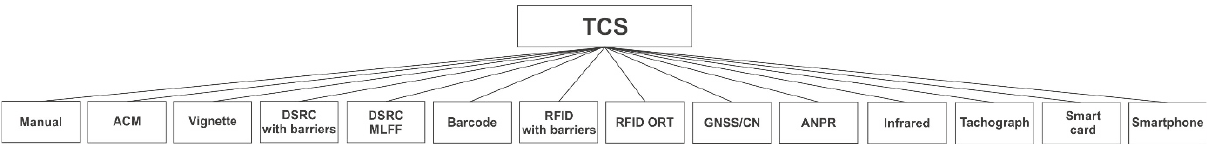
Figure 1: Toll collection systems.